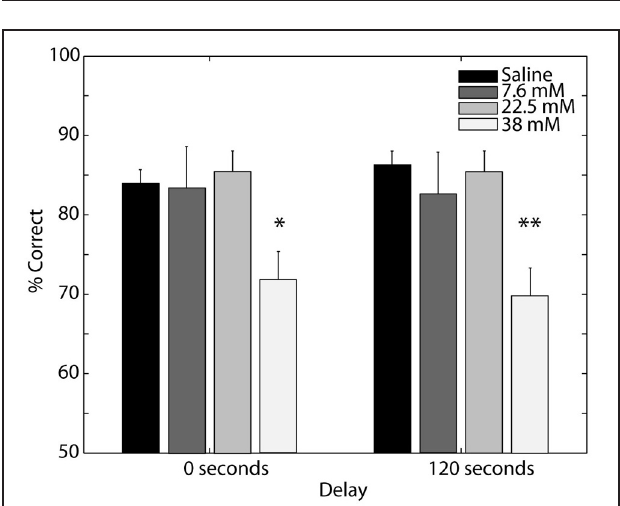
FIGURE 4 | Effect of blocking bulbar muscarinic receptors on delayed match-to-sample. Percent correct performance for the baseline (0s delay) and short-term (120s delay) memory tests after saline or scopolamine (7.6, 22.5, and 38mM) infusion into the olfactory bulb. Error bars indicate ± 1 SEM. Asterisks indicate significant differences of ∗ P < 0 . 05 and ∗∗ P < 0 . 005 relative to saline